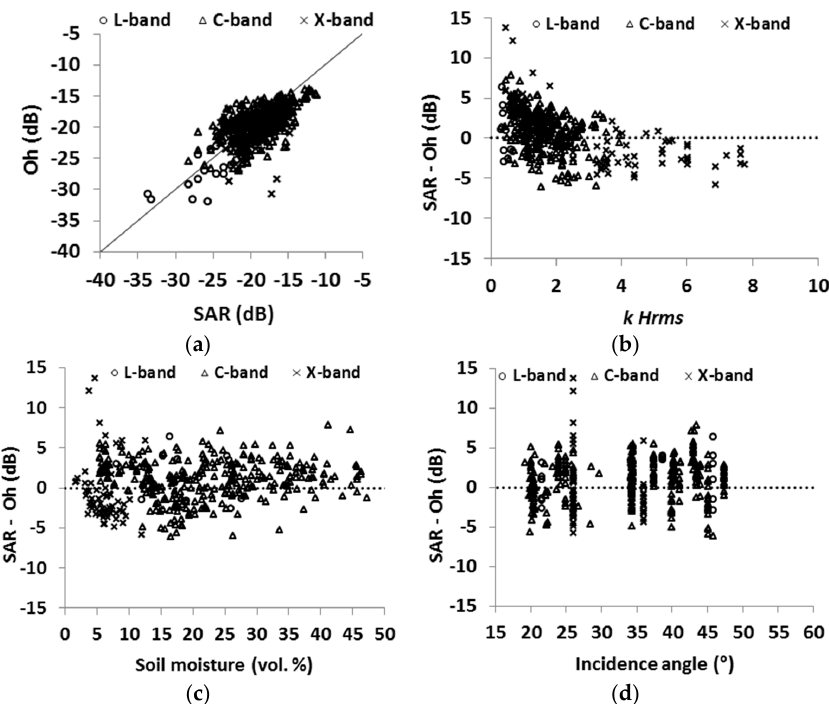
Figure 5. Comparison between backscattering coefficients derived from SAR images and those estimated from the Oh 2002 model at HV polarization, ( a ) Oh simulations vs. SAR data; ( b ) difference between SAR signal and Oh model results vs. soil roughness ( kHrms ); ( c ) difference between SAR signal and Oh model results vs. soil moisture ( mv ); ( d ) difference between SAR signal and Oh model results vs. incidence angle.